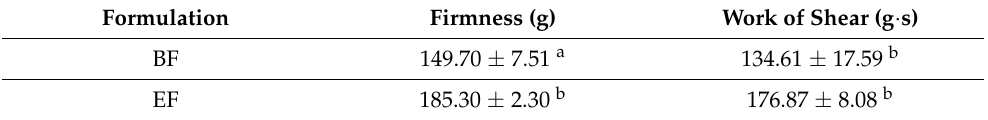
Table 3. Textural evaluation of firmness (g) and work of shear (g.sec) of both blank (BF) and extract (EF)